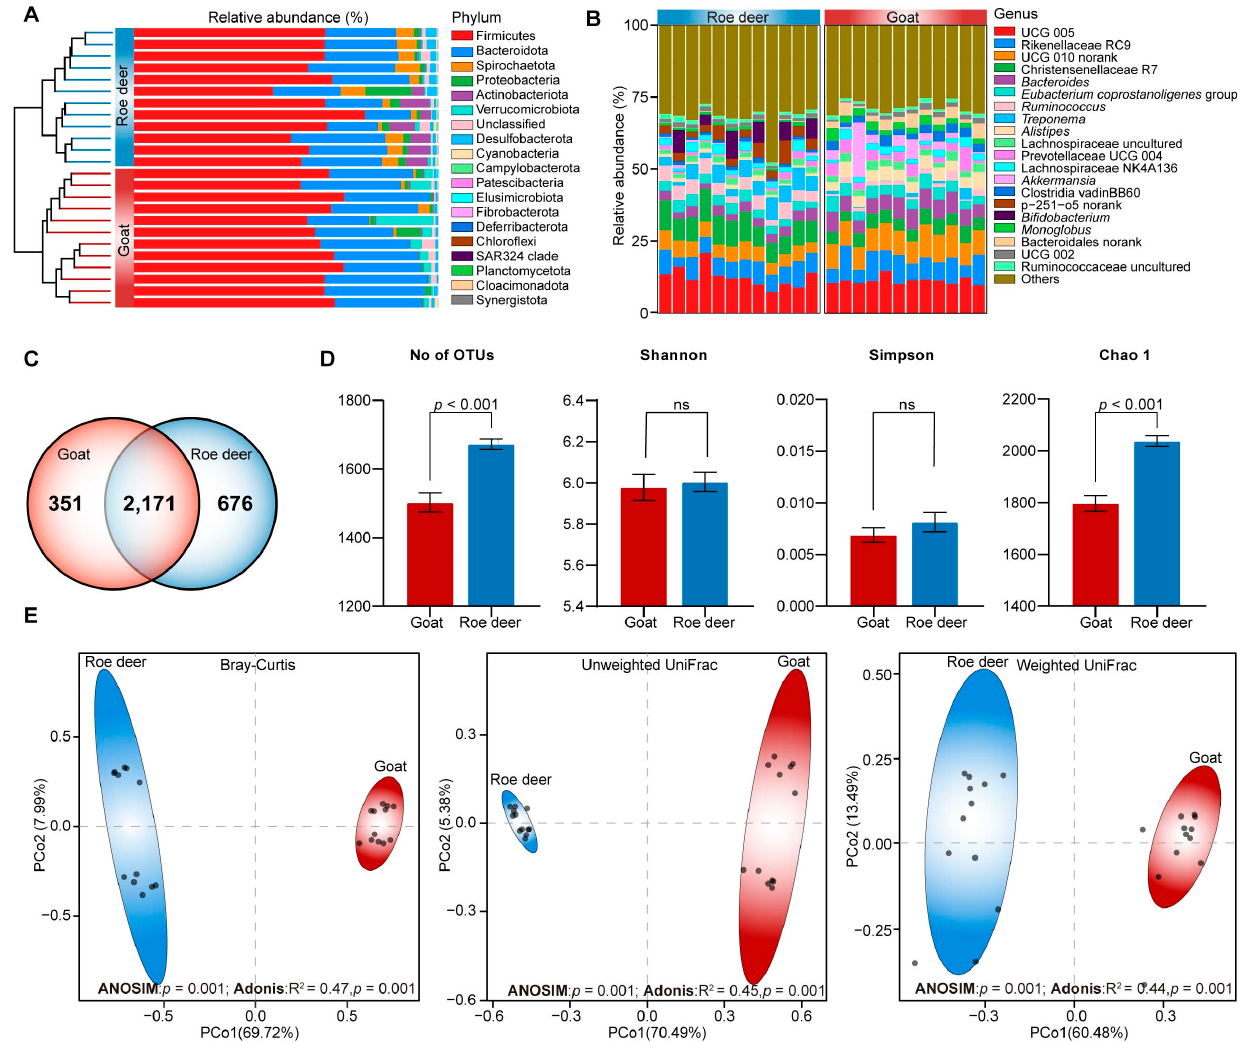
Figure 2. Bacteria community and composition in feces of roe deer and goats. ( A ) Clustering the bacterial composition in the feces of roe deer and goats at the phylum level; ( B ) bacterial community composition in feces of roe deer and goats at the genus level; ( C ) the shared and unique bacterial OTUs between roe deer and goats; ( D ) comparing the diversity indices in feces between roe deer and goats; ns means no significant differences; ( E ) PCoA shows the change of bacterial community based on the Bray–Curtis dissimilarity matrix, unweighted UniFrac distance, and weighted UniFrac distance at the OTU level. ANOSIM and Adonis analyses were used for statistical testing of group similarities and differences. The proportion of variation explained for each axis is given after the colon. Samples from roe deer and goats were clustered into blue and red ellipses.